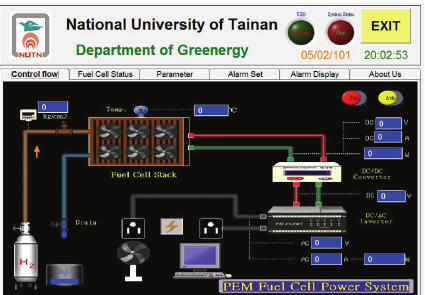
Figure 7: Home page of touch-sensitive human-machine